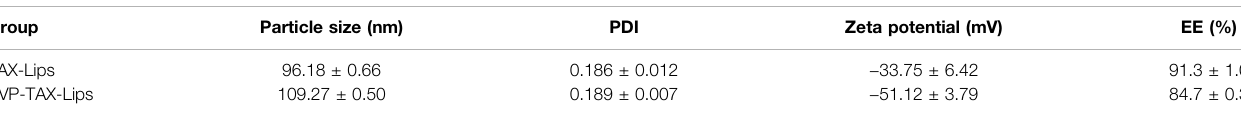
Data are presented as the mean ± SD (n =